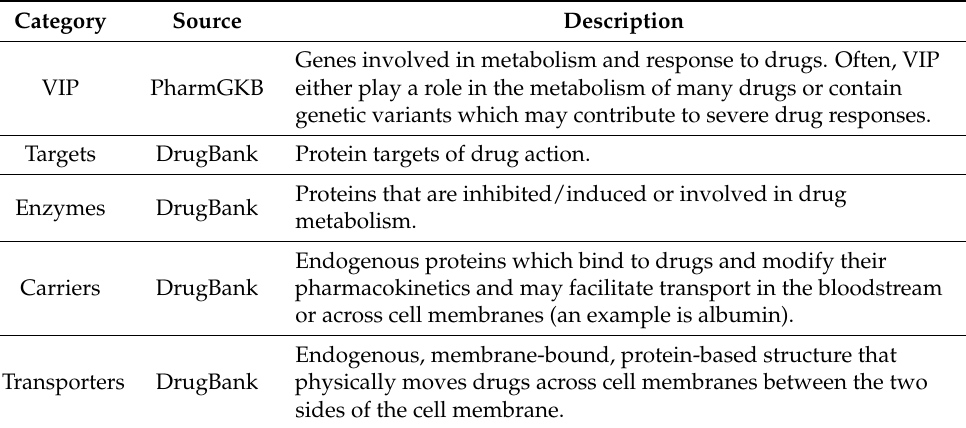
Table 2. Criteria for pharmacogenes transcripts